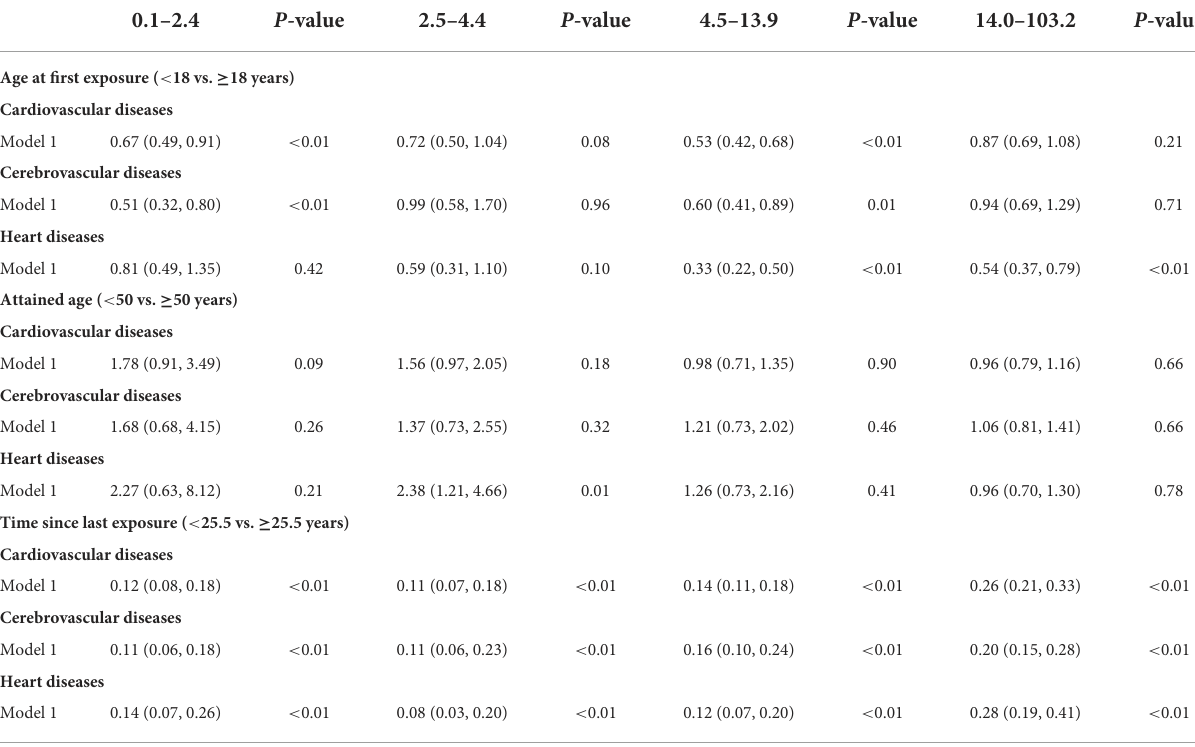
TABLE 5 Modification effects of the relationship between arsenic concentration and cardiovascular disease